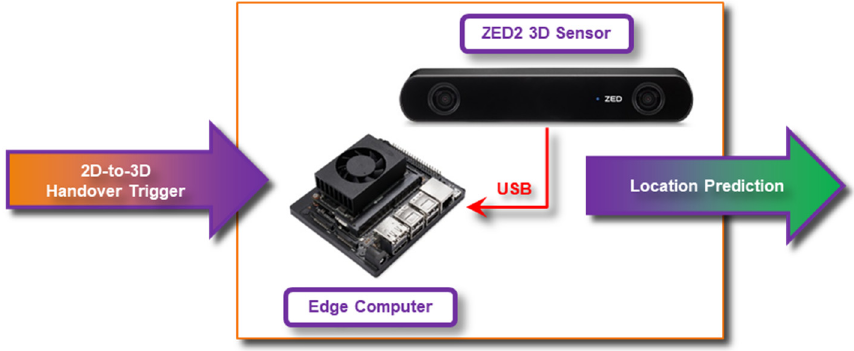
Figure 4. 3D Video system for predictions.